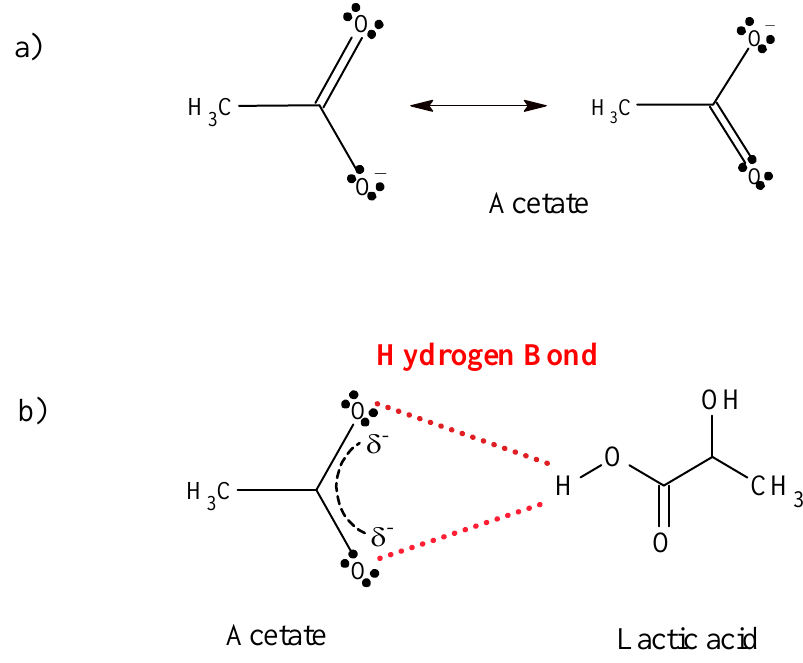
Figure 3. ( a ) Resonance stabilization of acetate ion. ( b ) Preferential interactions between lactic acid and acetate ion.